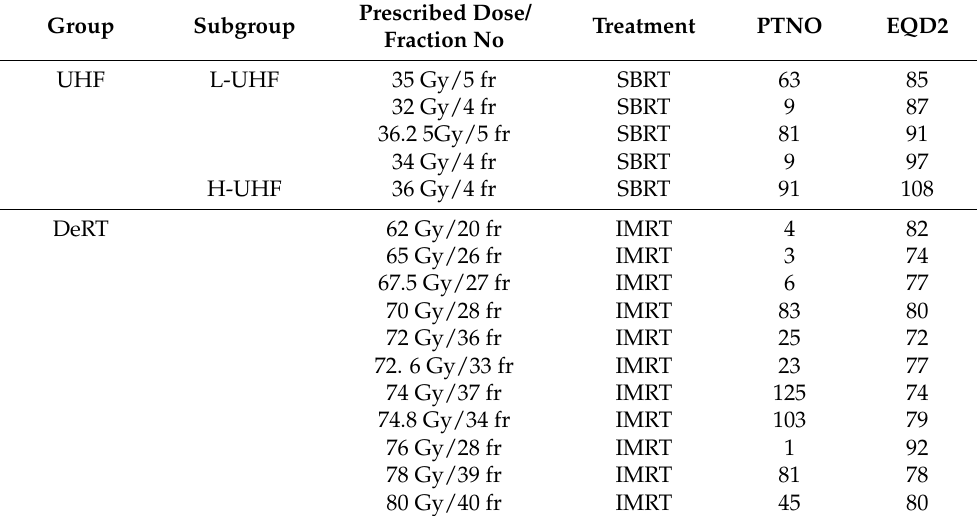
Table 2. Detailed treatment